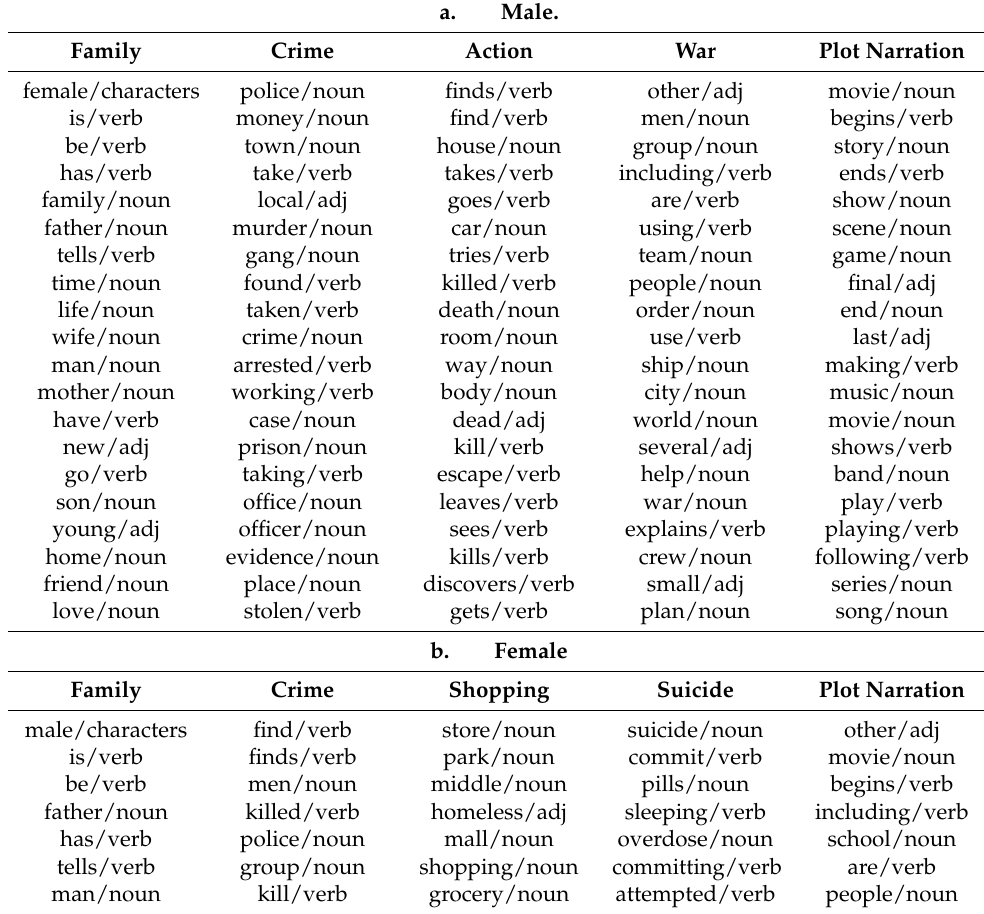
Table A1. Classification of each community under a specific